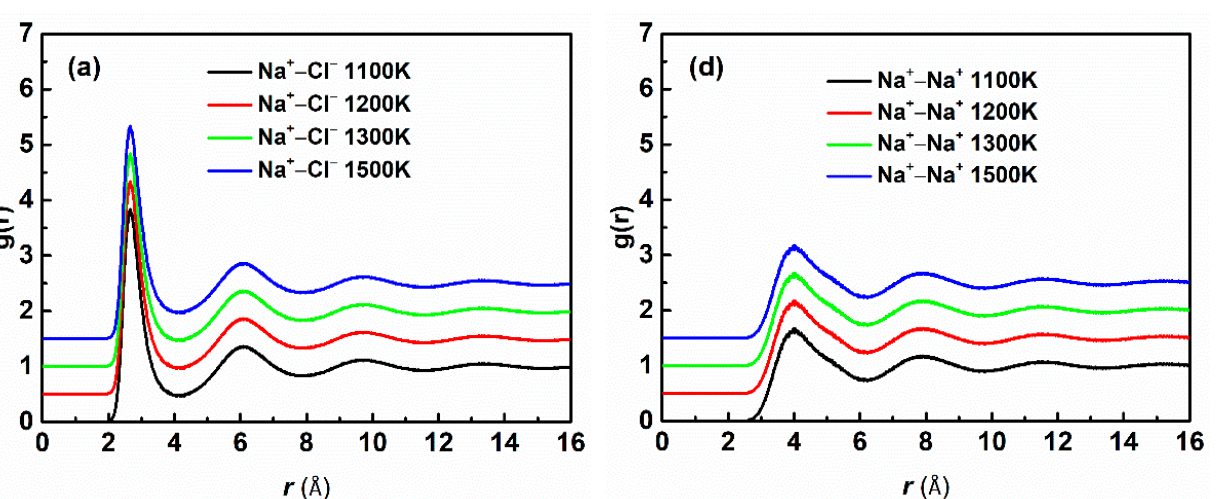
Figure 1. PIM simulated results of RDF: (i) The RDF of cation–anion in PIM ( a ) NaCl; ( b ) MgCl 2 ; ( c ) ZnCl 2 . (ii) The RDF of cation–cation in PIM ( d ) NaCl; ( e ) MgCl 2 ; ( f ) ZnCl 2 .